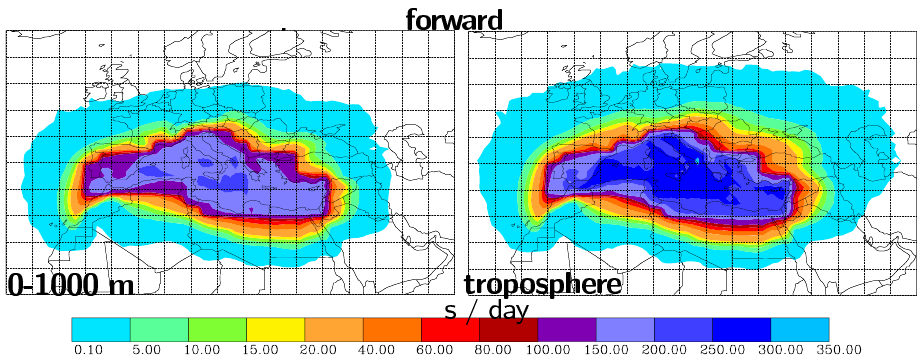
Fig. 2. One-day residence times in s/d for the Mediterranean basin calculated for the lowest layer, 0–1000m (left), and the whole troposphere (right) in forward